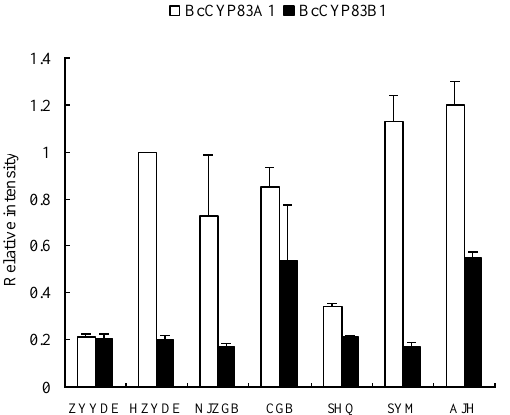
Figure 4. Relative expression analysis of CYP83A1 and CYP83B1 in leaves of seven cultivars of pak choi. Error bars represent the standard deviation (SD) from three biological repeats.